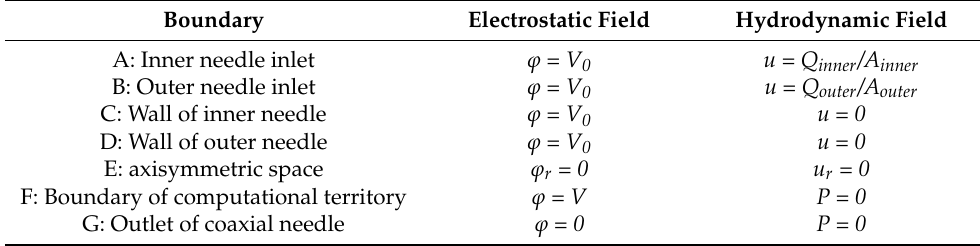
Table 2. The boundary conditions of the geometric